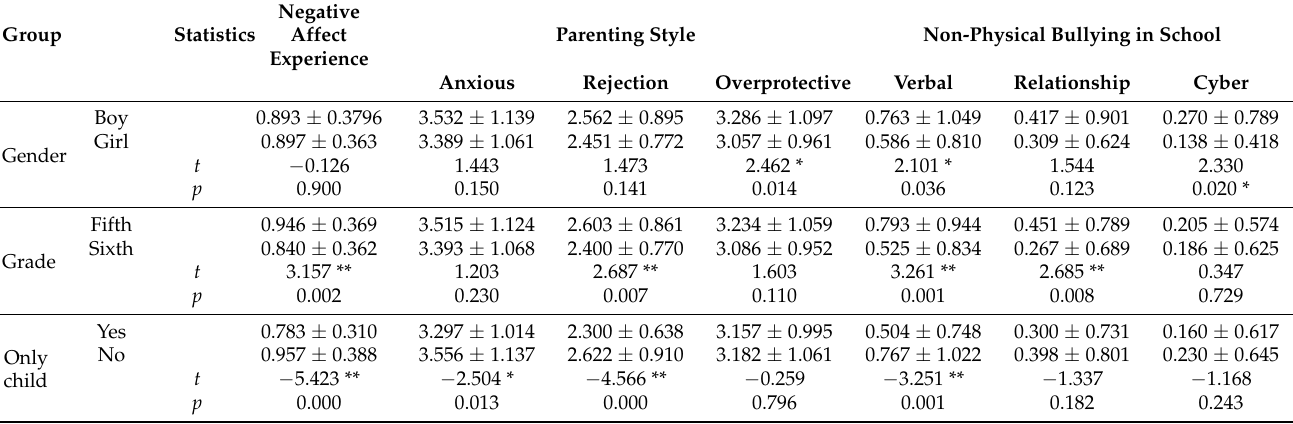
Table 2. Difference analysis of the scale scores of the present study (N =